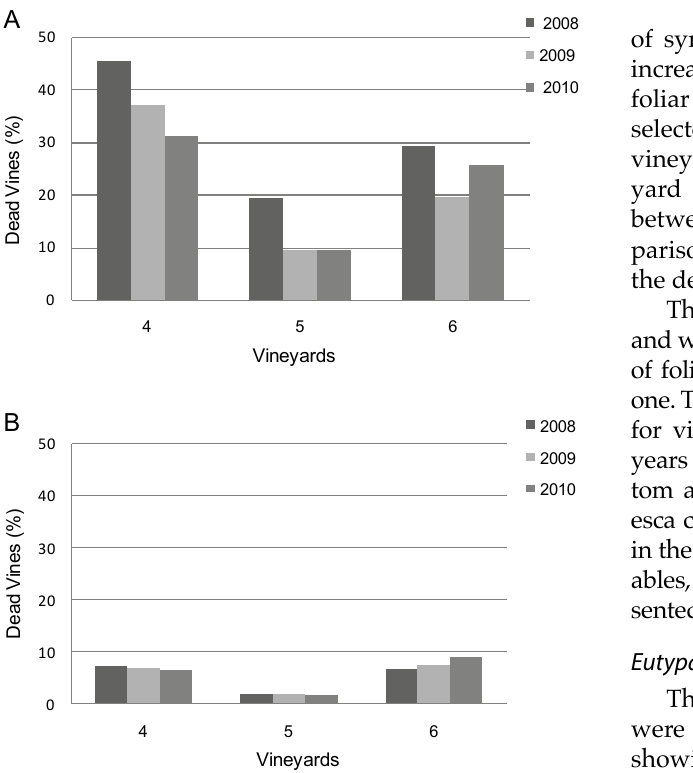
Figure 3. Percentage of dead vines in 2008, 2009 and 2010 among vines either expressing Eutypa dieback foliar symptoms previously (a), or among asymptomatic vines previously (b), in all three